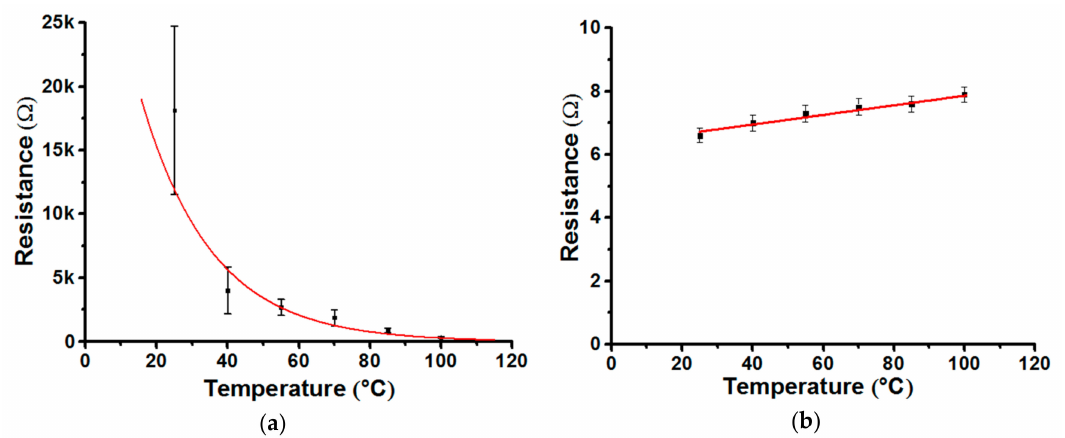
Figure 3. Temperature dependence of the resistance of dried and sintered lines after heat treatment for 60 minutes formed at temperatures of 100 ◦ C ( a ) and 400 ◦ C ( b ), respectively. The formation of this lines was carried out at T s = 25 ◦ C, N = 1 layer, FR = 5 and V s = 100 mm /